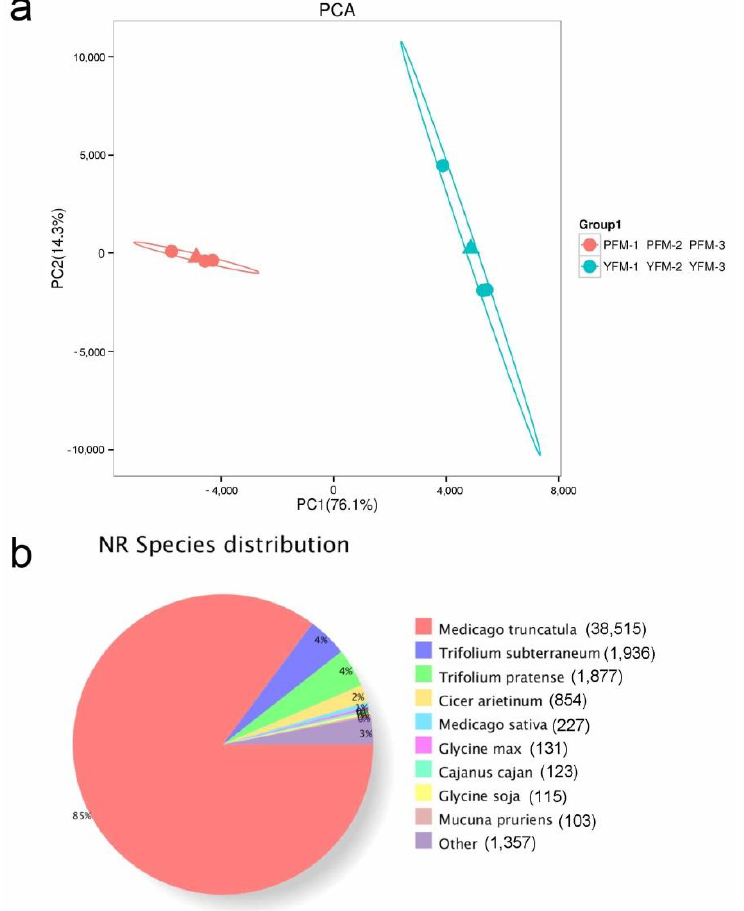
Figure 4. The preliminary statistics analysis (PCA) of RNA-sequencing. ( a ) PCA was performed on all RNA-seq samples. Petal samples in the bud phase were collected for transcriptomic analyses. PFM − 1–3 and YFM − 1–3 represent the three biological independent PFM and YFM samples, respectively. Total RNA was extracted from the petal samples using the TRIzol reagent (Invitrogen, Waltham, MA, USA) following the manufacturer’s instructions. All samples were sent to Biomarker Co., Ltd. (Beijing, China), and six cDNA libraries (including three replicates) were constructed and sequenced using the HiSeq 2000 platform (Illumina, San Diego, CA, USA) and the sequencing by synthesis (SBS) technique. The contributions of principal component 1 (PC1) and principal component 2 (PC2) were 76.1% and 14.3%, respectively. The result of PCA revealed that the six samples could be assigned to two groups. ( b ) NR annotation of unigenes of PFM and YFM. In comparison with other species, these unigenes of PFM and YFM showed the highest similarity with sequences from Medicago truncatula (85%, 38,515), Trifolium subterraneum (4%, 1936), and Trifolium pratense (4%,